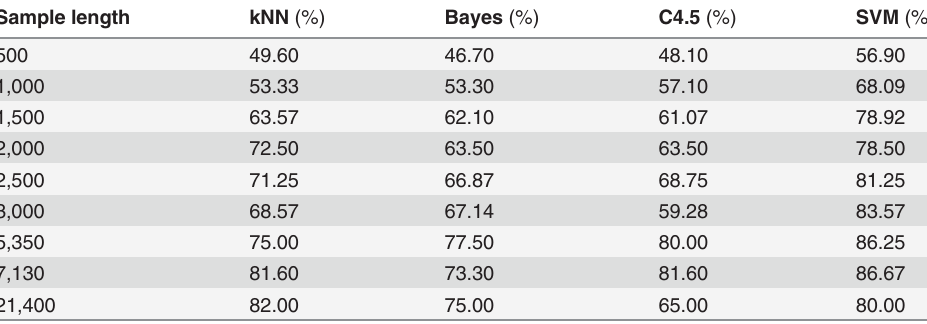
Table 4. Accuracy rate for the authorship recognition task.